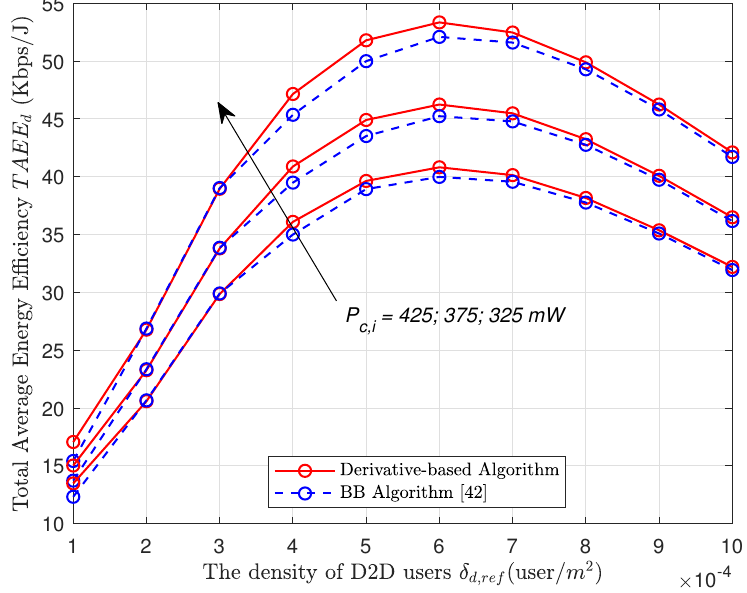
Figure 3. The TAEE of D2D communication in 3TS versus δ d , ref